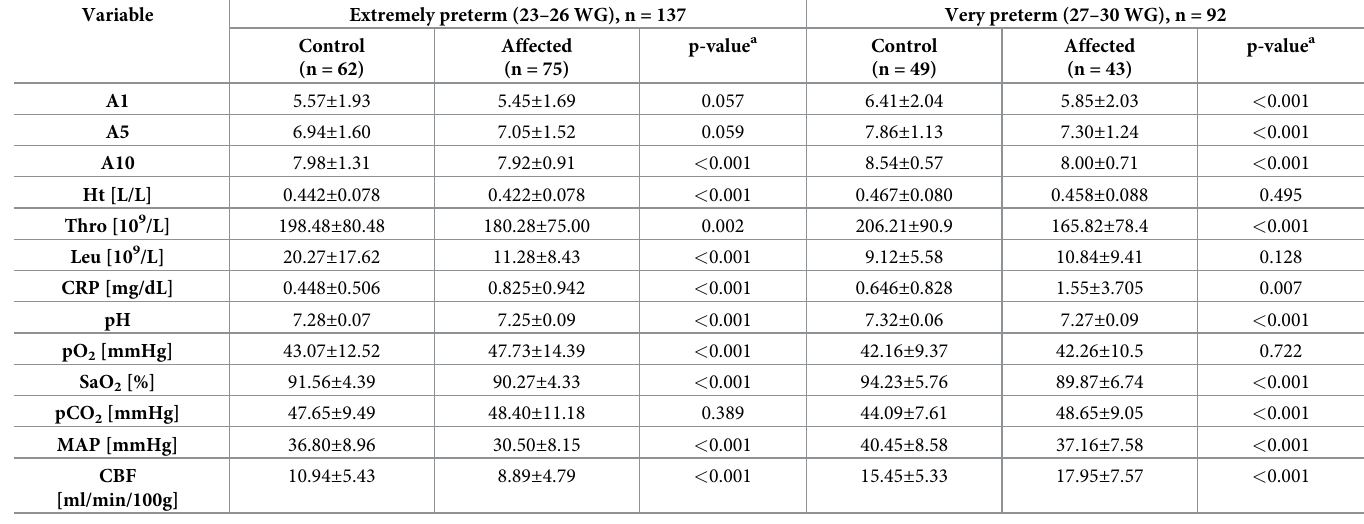
Table 5. Comparison of variable means for the control and affected groups. For the affected group only records taken before hemorrhage were considered for the model.